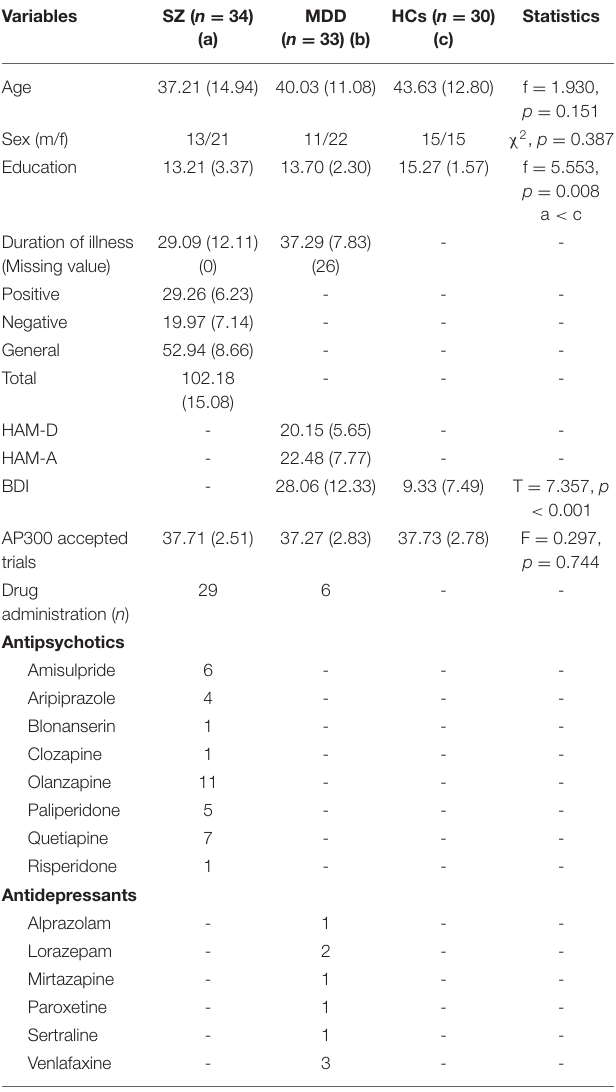
TABLE 1 | Demographic data of the present